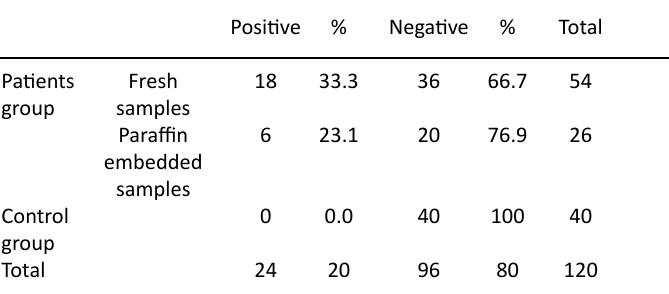
Table 4. Detection of the Epstein Barr Virus